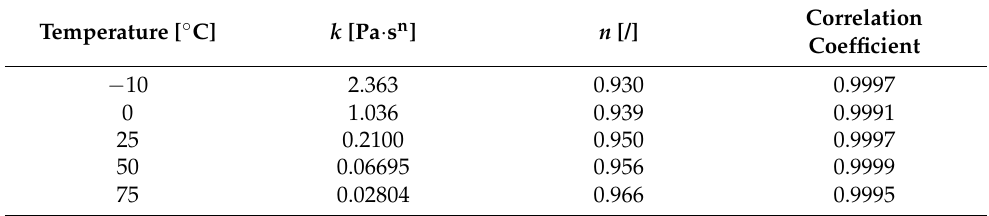
Table 2. Consistency index and flow behavior index of 10W40 engine oil at different